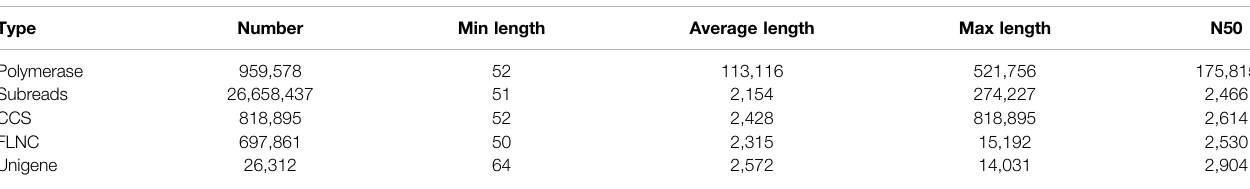
TABLE 1 | Description of full-length sequencing in Cipangopaludina chinensis